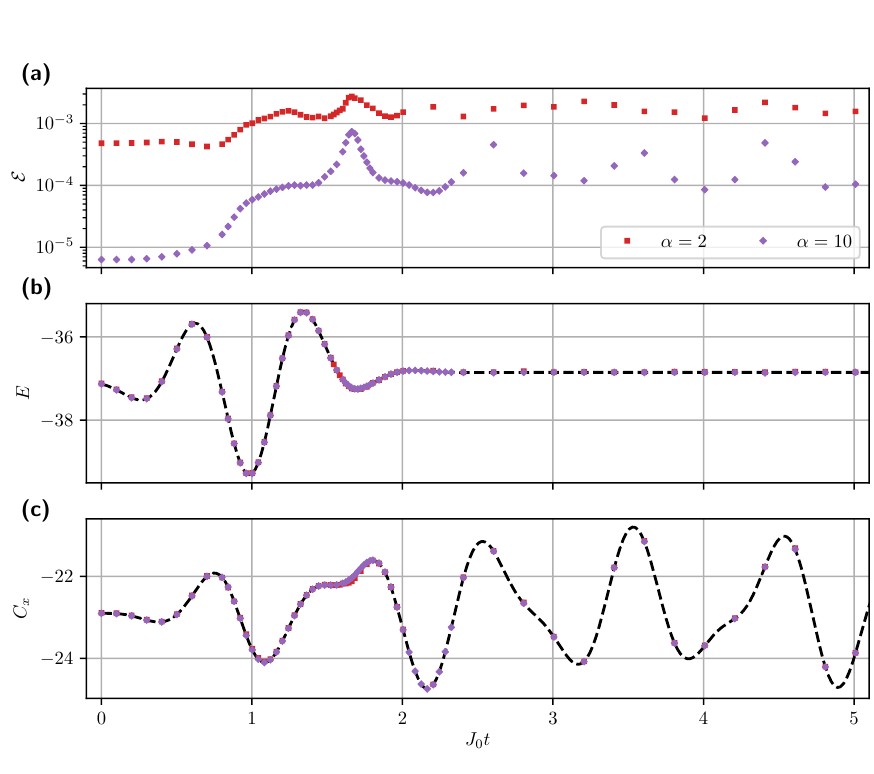
Figure 12: (a) Infidelity [ Eq. (11) ] , (b) energy, and (c) spin-spin correlation C α = 2 and α = 10 RBM states obtained from supervised learning of the amplitudes along the exact trajectory at an excitation strength of A the best-fidelity results among five independently optimized states are displayed.